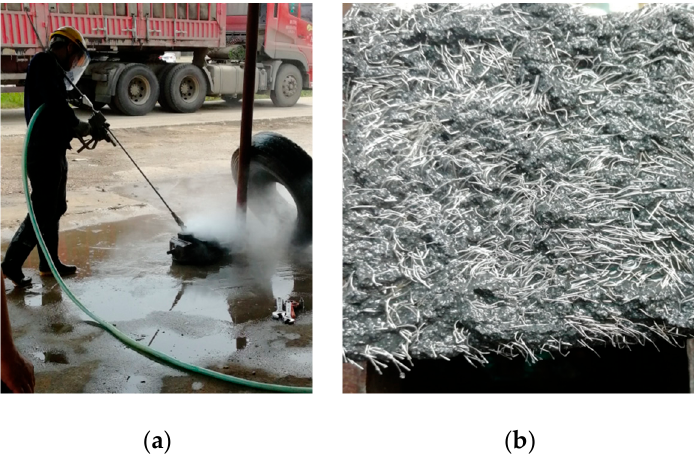
Figure 4. Interface treatment with a high-pressure waterjet. ( a ) Waterjet; ( b ) surface treatment.